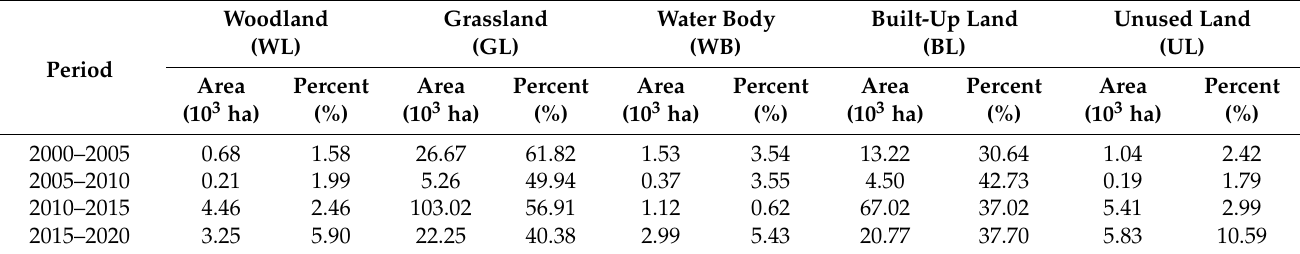
Table 7. Statistics on the destinations of lost cropland in Xinjiang during